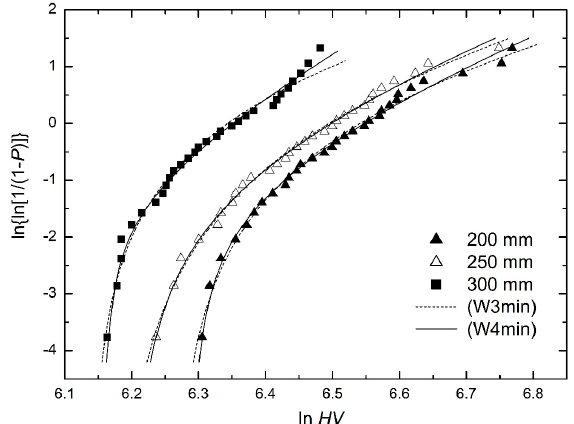
Figure 14. Weibull plots for Vickers hardness of Nd–Fe–B coatings plasma sprayed from the 200 mm, 250 mm, and 300 mm standoff distances [16] using the (W3min) and (W4min) CDFs. Table 4. Comparison of the sums of least squares S and the values of the t 0 parameter in the Weibull plots for Vickers hardness of Nd–Fe–B coatings plasma sprayed from the 200 mm, 250 mm, and 300 mm standoff distances [16] using the (W3min) and (W4min) CDFs. Quantity S t 0 [HV]